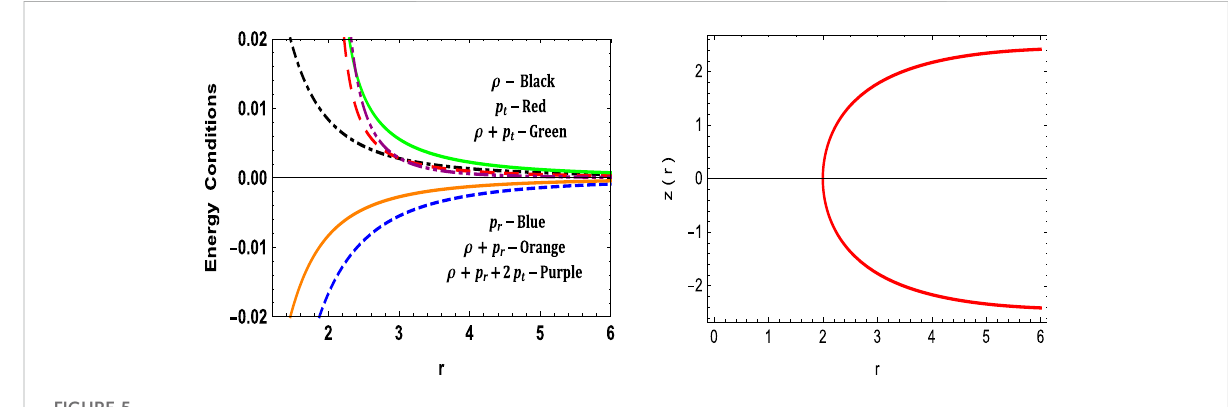
FIGURE 5 Variation of energy conditions and embedding surface for model II with a = 2, λ = 1.2, ω = − 2, c = − 0.16.